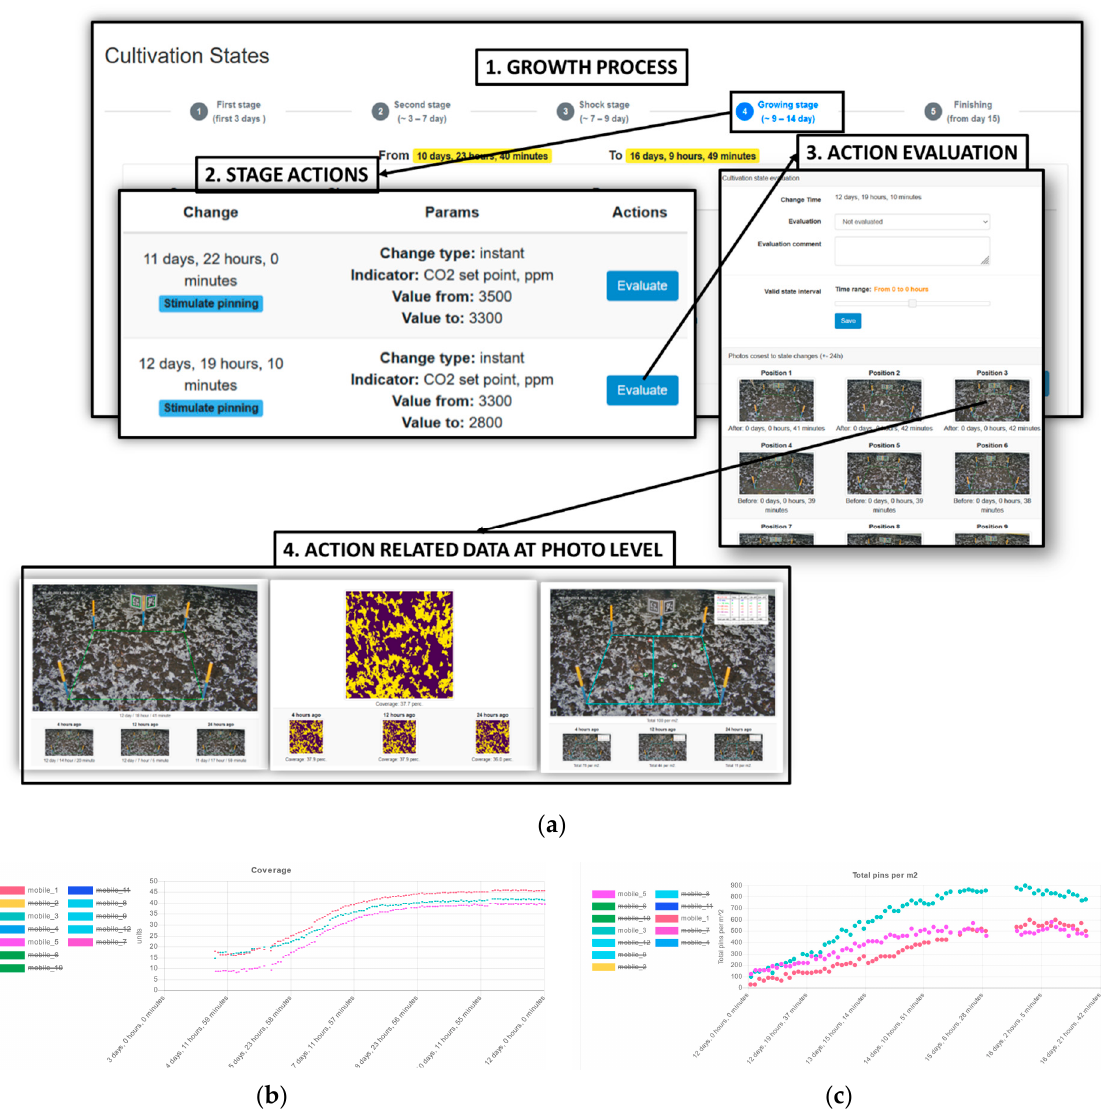
Figure 10. Parts of technologist interface to access the data related to the past growth process. ( a ) workflow of evaluating the performed changes; ( b ) example of dynamics of mycelium coverage percent in the selected monitored positions; ( c ) dynamic of total number of pins in the selected monitored positions.